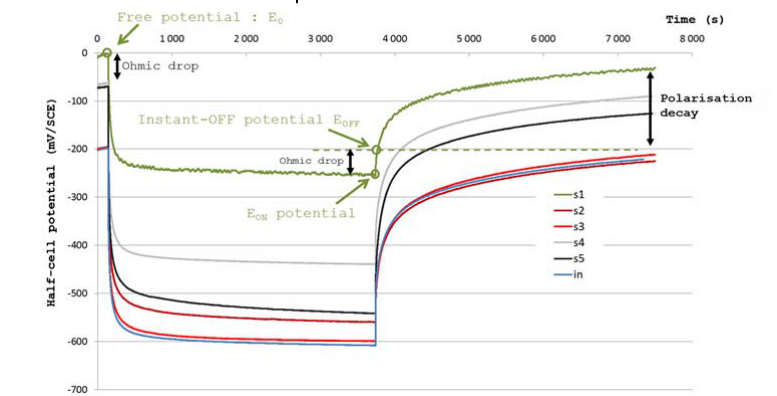
Figure 3. ICCP experiment ‐ polarization and depolarization processes (all potentials are expressed versus SCE reference).